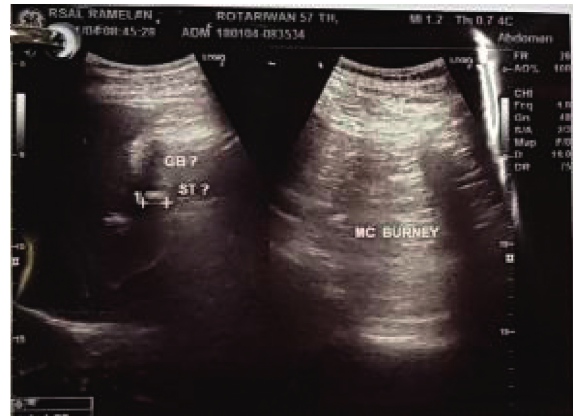
Figure 1: Abdominal ultrasound: normal gall bladder with stones without dilatation of the bile duct.